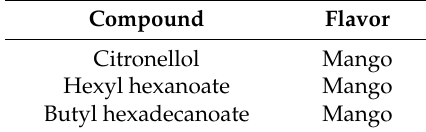
Table 7. Compounds observed in e-liquid and filter pads.